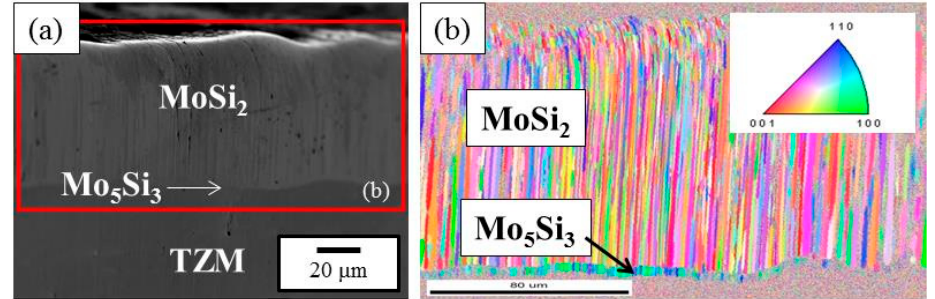
Figure 3. ( a ) Cross-section of MoSi 2 -coated TZM alloys at 1100 ° C for 24 h; ( b ) shows the electron backscatter diffraction (EBSD) micrographs of the marked area in ( a ).